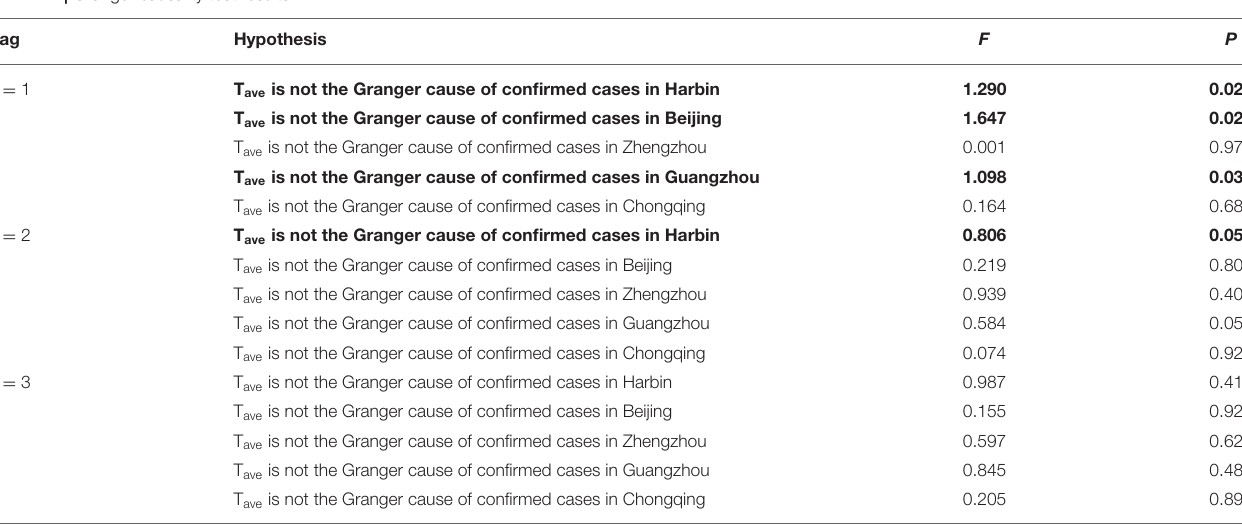
TABLE 4 | Granger causality test results.